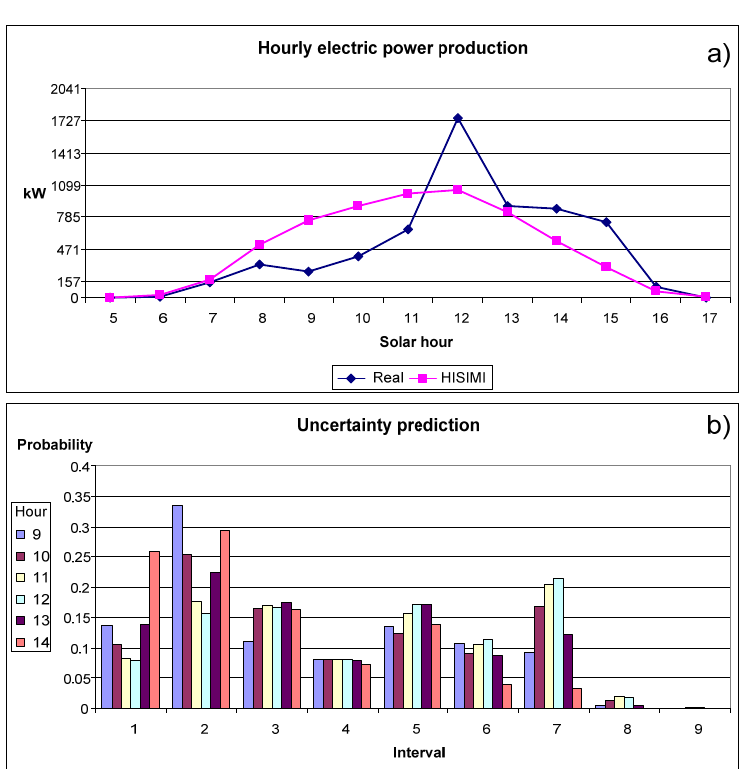
Figure 11. Forecasted hourly power production ( a ) and uncertainty prediction for six central hours; ( b ) (from 9:00 to 14:00) on a rainy